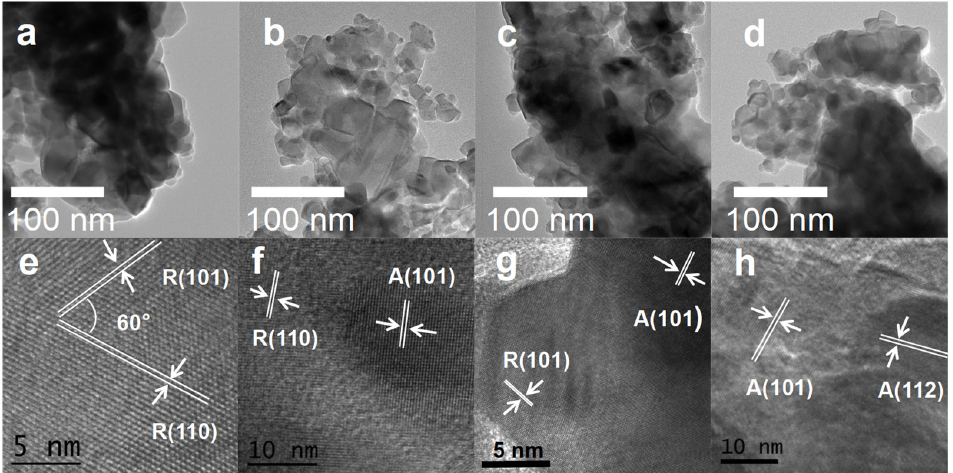
Figure 3. TEM and HR-TEM images of nano-TiO 2 from ( a , e ) CT650-R0, ( b , f ) CT650-R5, ( c , g ) CT650-R15 and ( d , h ) CT650-R25.